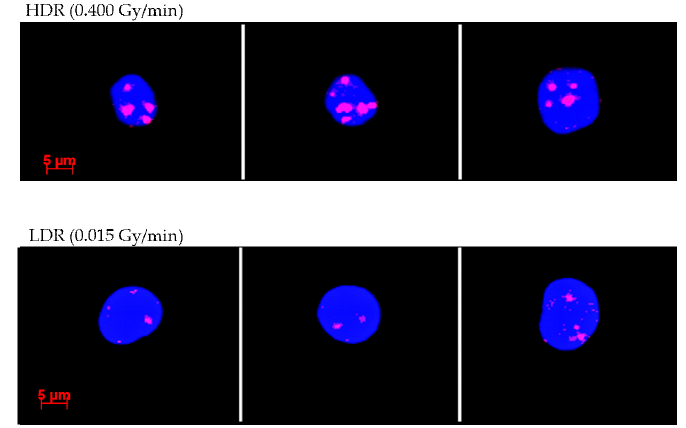
Figure 2. Images retrieved from the Metafer automatic image analysis software representing γ -H2AX foci in lymphocytes exposed to HDR (0.400 Gy/min—top) and LDR (0.015 Gy/min—bottom) neutrons. Red dots indicate γ -H2AX foci, while the nuclei are stained blue with a fluorescent DNA stain, namely 4 (cid:48) ,6-diamidino-2-phenylindole (DAPI). A ratio was calculated of the HDR over the LDR induced DNA DSB values, ranging between 1.16 and 1.87 for neutron doses of 0.125 to 2.000 Gy, with a maximum di ff erence between LDR and